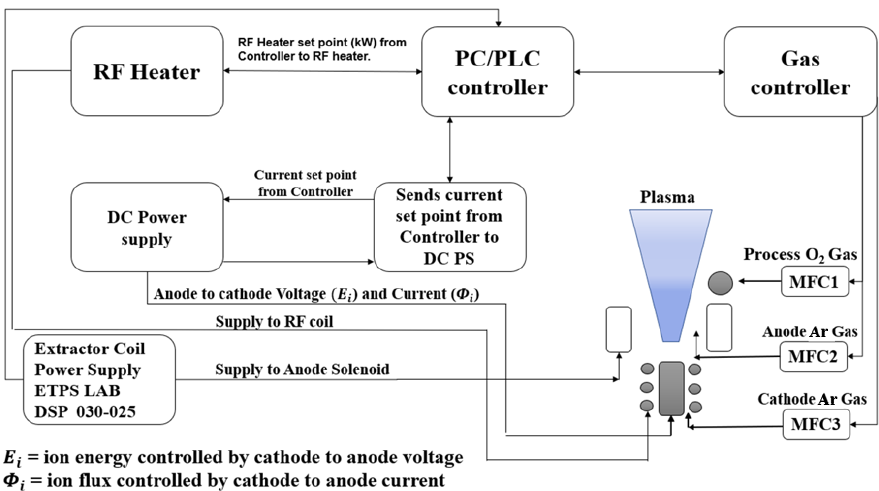
Figure 4. Plasma source operation and control loops block diagram—personal computer/programmable logic controller (PC/PLC), mass flow controller (MFC).